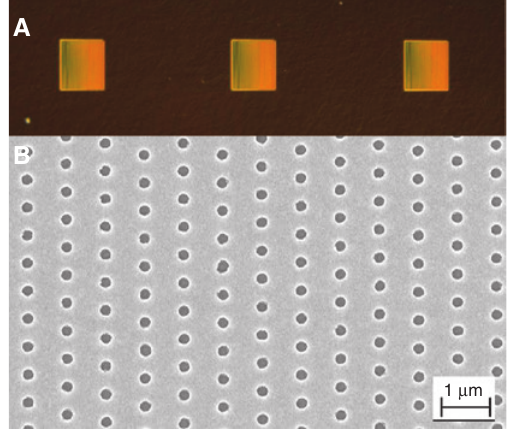
Figure 2: Images of the array. (A) Reflection image of the multiperiodic nanohole array under white light illumination, using crossed polarizers. The sample reflects a different color, which is dependent of the periodicity. (B) SEM image of the nanohole array with a 1-nm increment changing period (the total sample goes from 500 to 600 nm) in the x-axis and a 700-nm period in the y-axis. The hole size is 180 nm, and the thickness of the gold film is 100 nm.